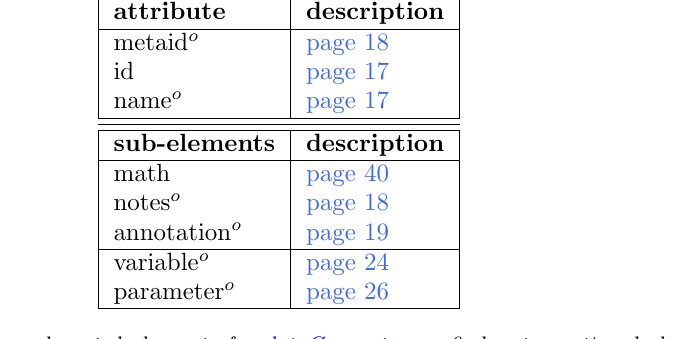
Table 2.23: Attributes and nested elements for dataGenerator. xy o denotes optional elements and